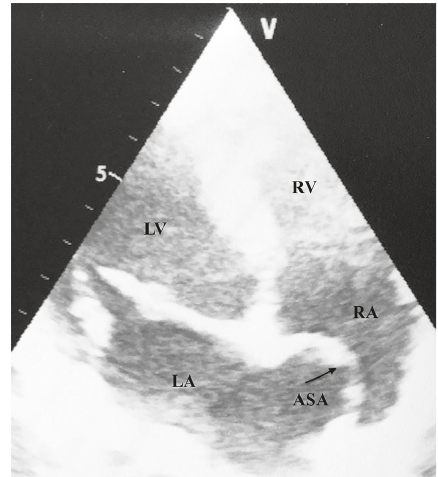
Figure 2: Apical four chamber view of atrial septal aneurysm detected by transthoracic echocardiography. ASA: atrial septal aneurysm, LV: left ventricle, LA: left atrium, RV: right ventricle, and RA: right atrium.